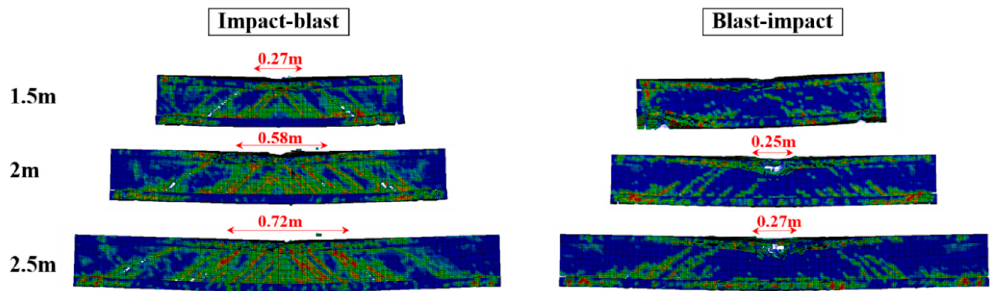
Figure 9. Damage states of beams under combined loads of different beam spans.